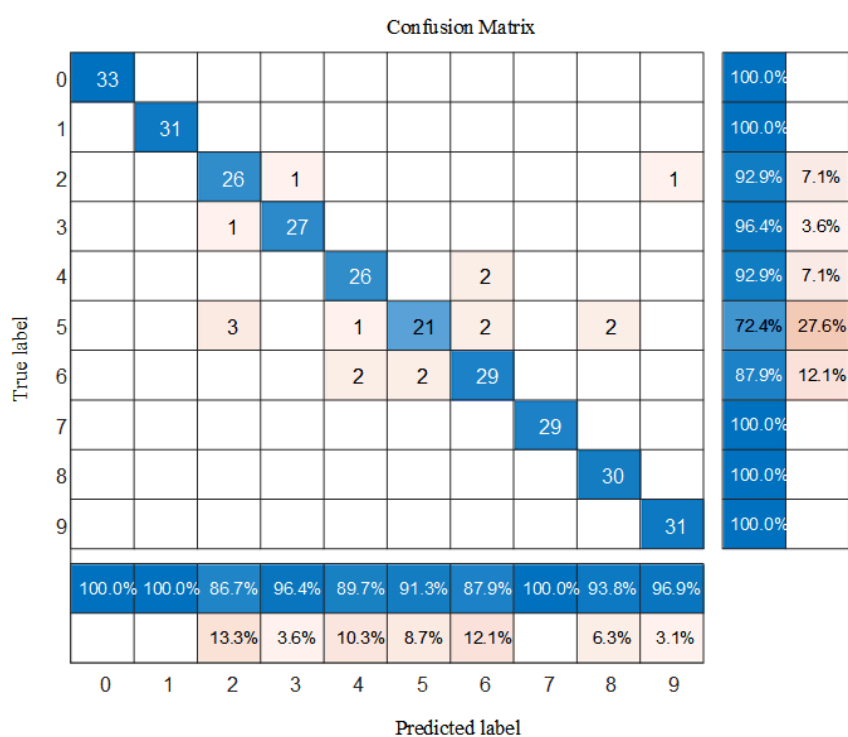
Figure 7. Confusion matrix for the CWRU dataset identification results.